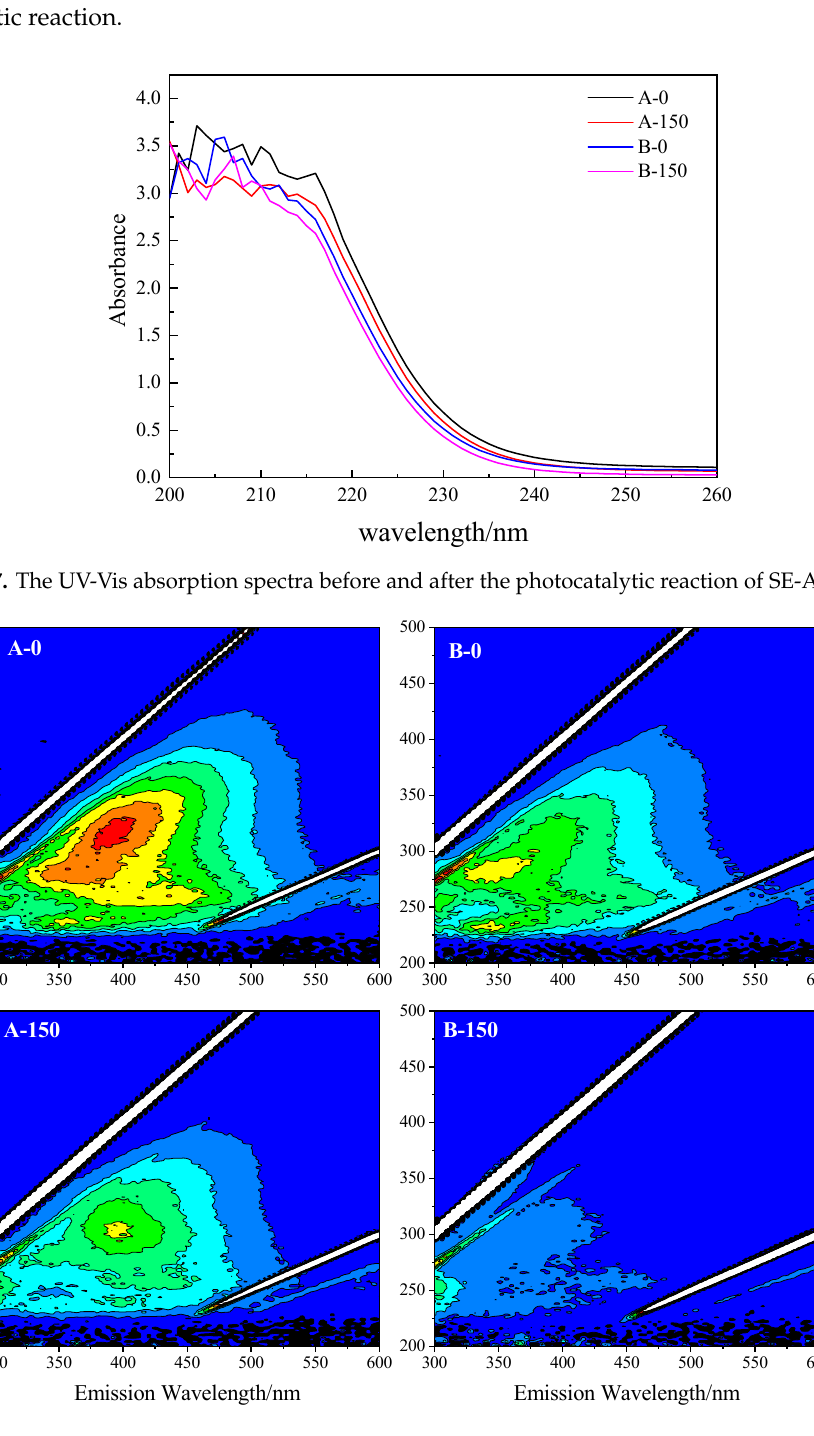
Figure 8. The changes of three-dimensional fluorescence of DOM in SE-A and SE-B after the photocatalytic degradation of TiO 2 .